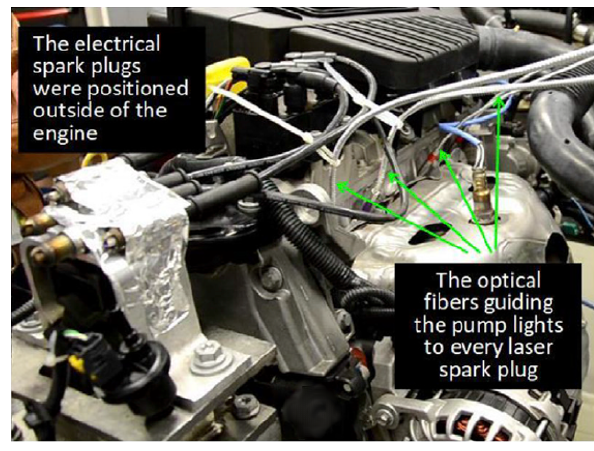
Figure 15: View of a Renault engine ignited by means of laser spark plugs during the carried out experimental test by researchers in [5,